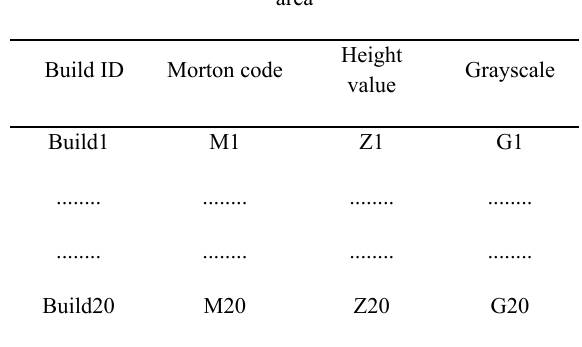
Table 5. Data structure table represented by the yellow